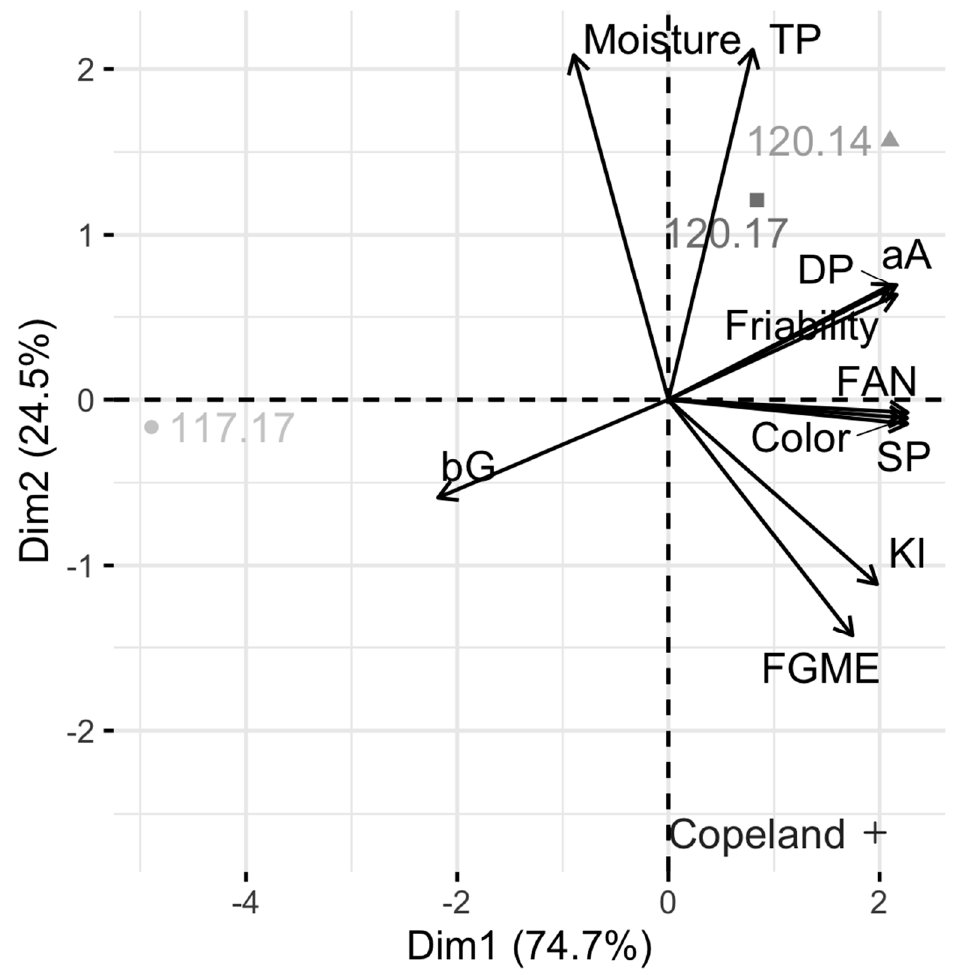
Figure 1. Principal component analysis of the commercial-scale malts used to produce the beers for the consumer sensory evaluation. Biplots shows the first principal component (Dim1) and second principal components (Dim2). Malt quality traits include moisture content (%), total protein (TP; %), diastatic power (DP; °L.), α -amylase (AA; D.U.), friability (%), free amino nitrogen (FAN; mG/L), wort color (color; °SRM), soluble protein (SP; %), the Kolbach index (soluble to total protein ratio; KI; %), fine grind malt extract (dry basis; FGME; %), and β -glucan content (ppm). Table 3. Malt quality data presented for the commercial-scale malts used to produce the beers for the consumer sensory evaluation.